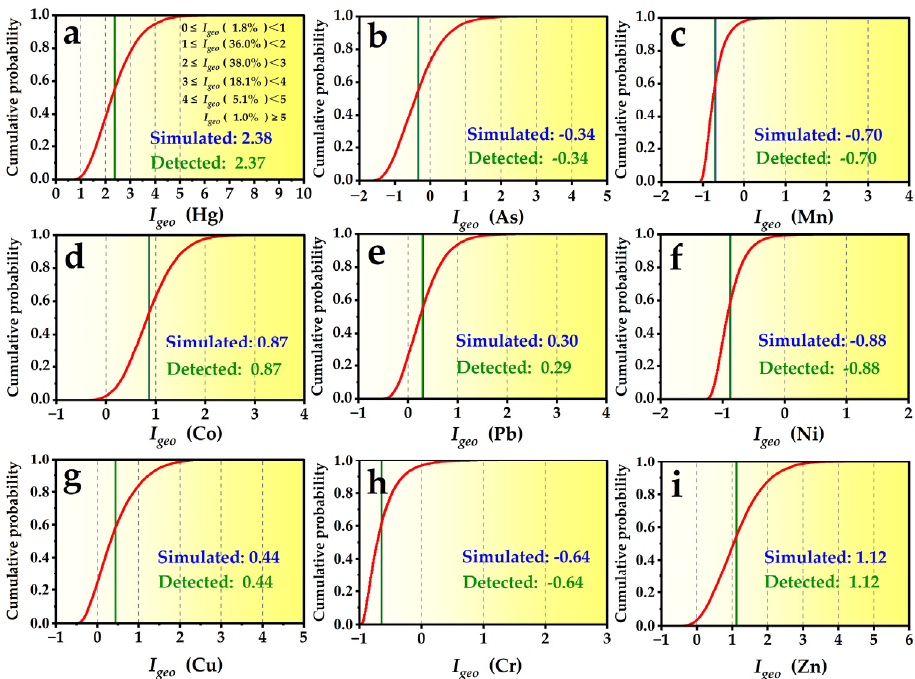
Figure 1. The geo-accumulation index of all HMs in the RSD based on MCS. ( a ) I geo (Hg); ( b ) I geo (As); ( c ) I geo (Mn); ( d ) I geo (Co); ( e ) I geo (Pb); ( f ) I geo (Ni); ( g ) I geo (Cu); ( h ) I geo (Cr); ( i ) I geo (Zn).